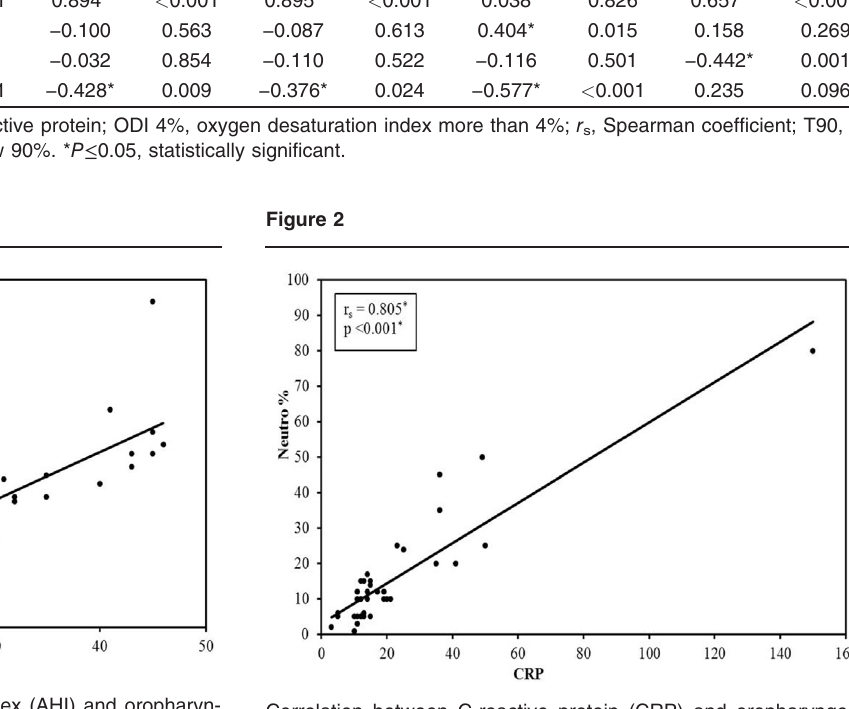
Correlation between apnea – hypopnea index (AHI) and oropharyn- geal lavage (OPL)